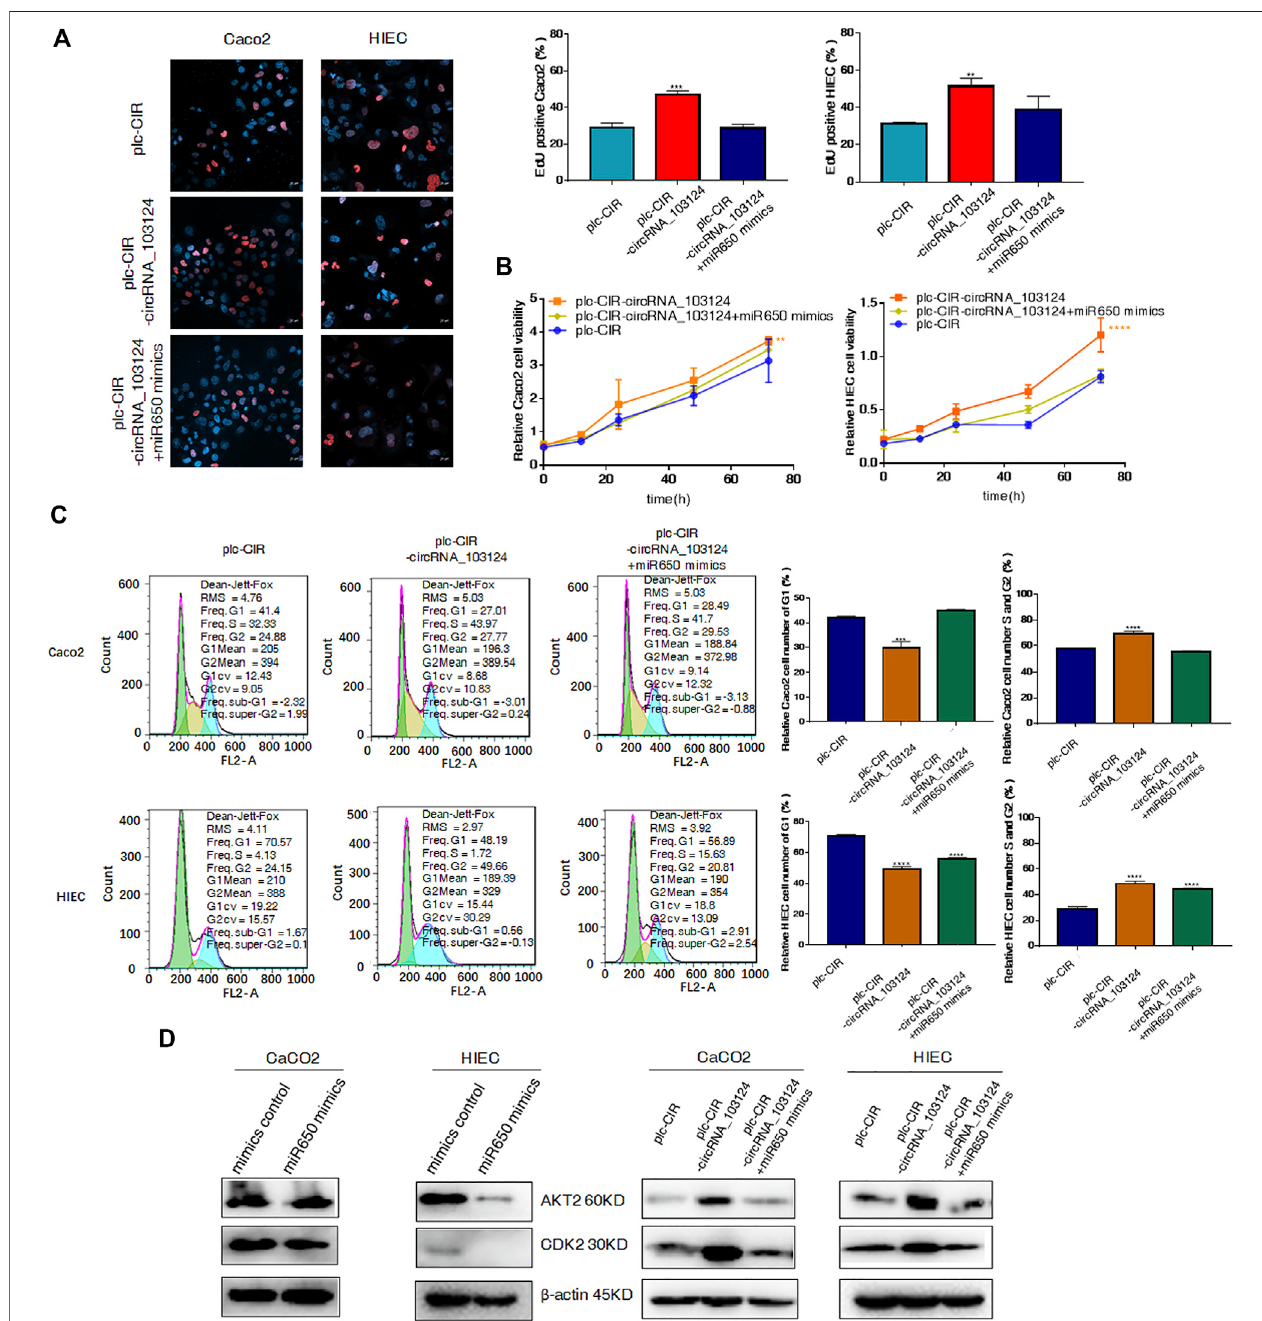
FIGURE5| Hsa-miR-650 mimicsreversedthepromotionofcellproliferationinducedbyhsa_circRNA_103124overexpression. (A – C) Cellproliferationwastested using 5-ethynyl-2 ′ -deoxyuridine staining, the CCK-8 assay and fl ow cytometry. (D) Relative expression of AKT2 and CDK2 was detected using western-blotting, and normalizedto β -actin.plc-CIR,cellstransfectedwithplasmidcontrolplc-CIR;plc-CIR-circRNA_103124,cellstransfectedwiththehsa_circRNA_103124overexpressed plasmid plc-CIR-circRNA_103124; plc-CIR-circRNA_103124 + miR650 mimics, cells cotransfected with the hsa_circRNA_103124 overexpressed plasmid plc- CIR-circRNA_103124 and hsa-miR-650 mimics. mimics control, cells transfected with the negative control of hsa-miR-650 mimics. miR650 mimics, cells transfected with hsa-miR-650 mimics.